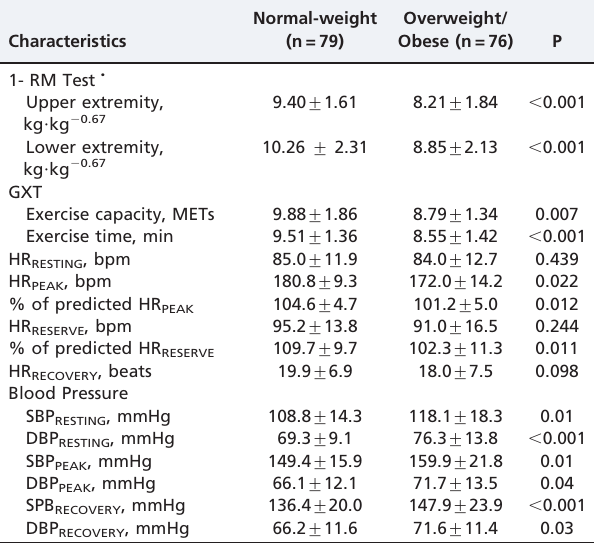
Table 2 - Baseline muscle strength, cardiorespiratory fitness, heart rate and blood pressure response to exercise.